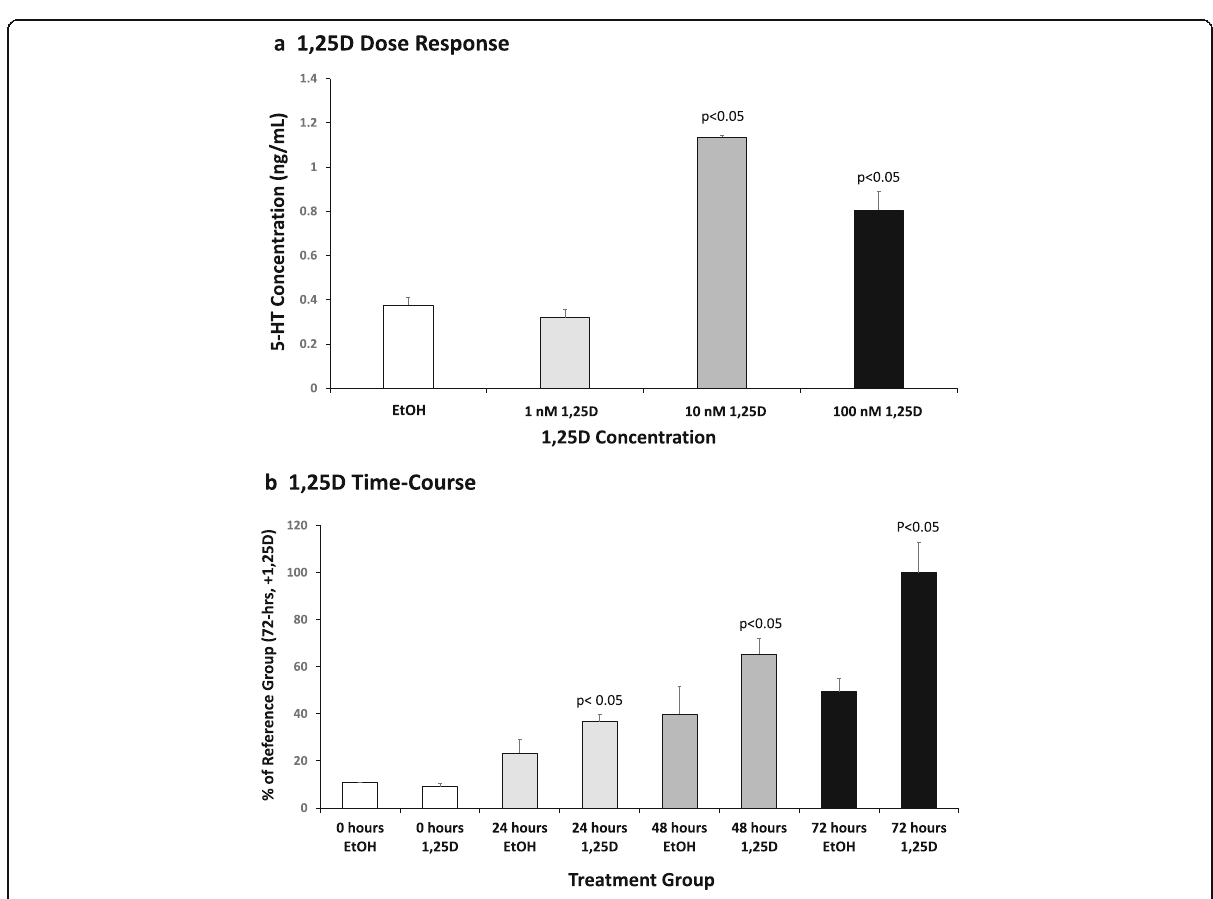
Fig. 5 Effect of 1,25D on total 5-HT levels in rat serotonergic neuron cell culture medium. a A dose-response experiment was performed in serotonergic rat raphe RN46A-B14 cells treated with the indicated concentrations of 1,25D or ethanol (EtOH) vehicle. A 200 μ L sample of medium was removed from each plate after 72 h of treatment and 5-HT quantitated by ELISA as detailed in the “ Methods ” section. Values are the average of three biological replicates ( n = 3) ± SD, with duplicate or triplicate samples averaged in each group. b A time-course experiment was carried out in RN46A-B14 cells treated with the optimal concentration of 1,25D (10 nM) for 0, 24, 48, and 72 h followed by removal of a 200 μ L sample of medium from each plate and serotonin assayed by 5-HT ELISA. Values are the average of three biological replicates ( n = 3) ± SD, with duplicate or triplicate sample groups averaged in each